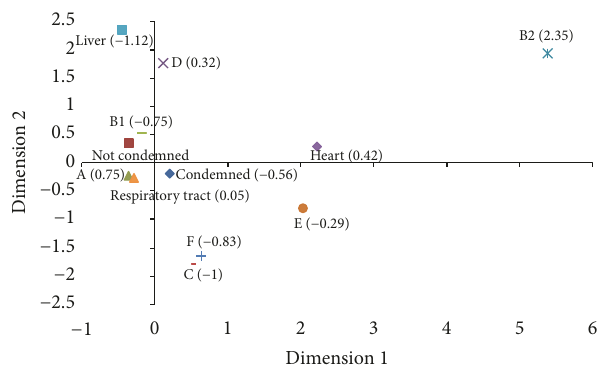
Figure 3: Correspondence analysis for the categories. This two- dimensional representation explains 42.52% of the total variation with 15.59% explained by 1st dimension, 13.86% by the 2nd dimen- sion, and 13.07% by the 3rd. The value of the third dimension is shown in